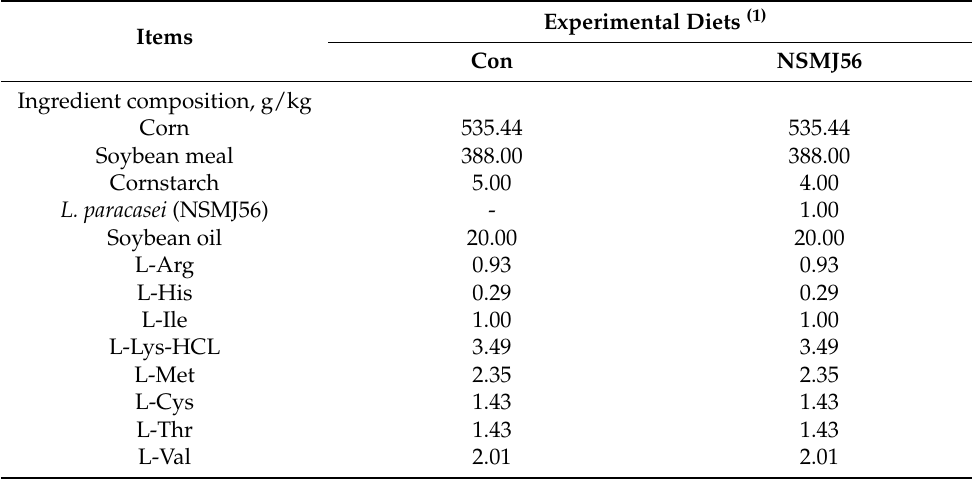
Table 1. Ingredients and chemical compositions of experimental diets (as-fed